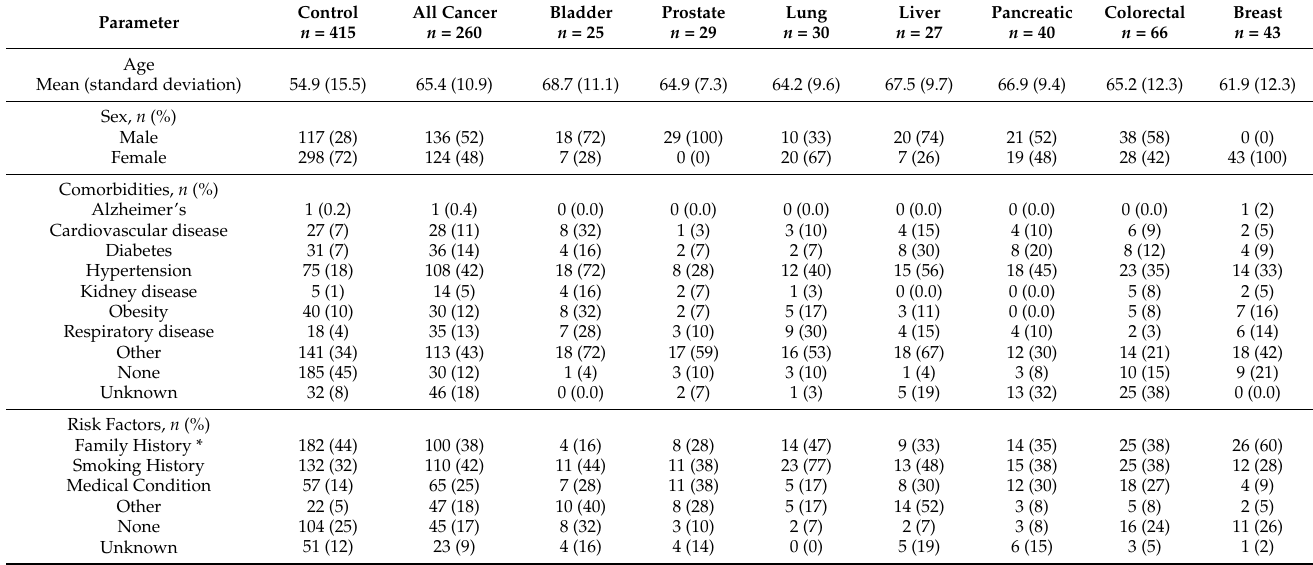
The overall detection sensitivity in the machine learning model for all cancers was 57% (CI: 52, 64) at 95% specificity, and 43% (CI: 37, 49) at 99% specificity. The area under the curve (AUC) for this model was 0.90. A receiver operating characteristics (ROC) curve for the “all cancers” model is shown in Figure 1.